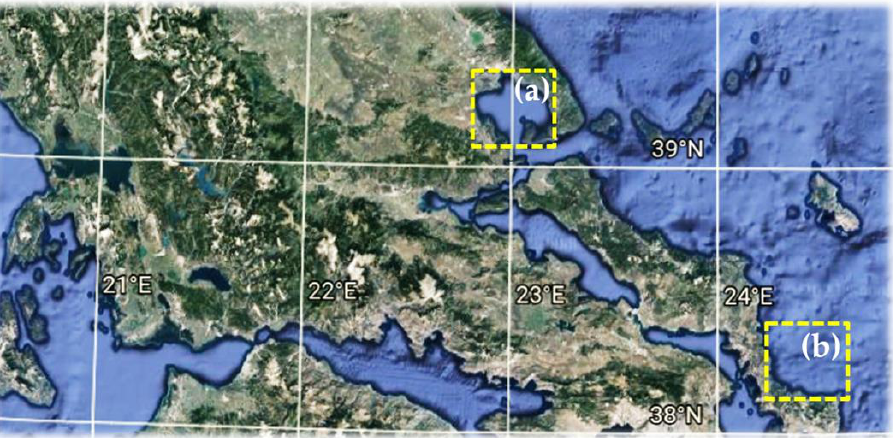
Figure 4. Nearshore areas considered for FPV module deployment. ( a ) Pagasistikos Gulf area, and ( b ) SE coastal region of Evia Island.